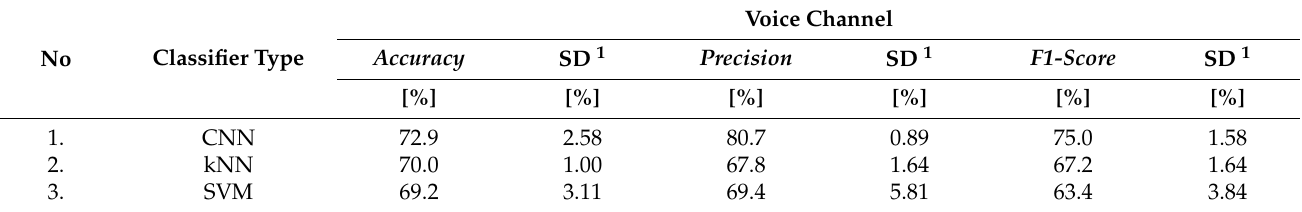
Table 4. Effectiveness of automatic detection of affective states in voice